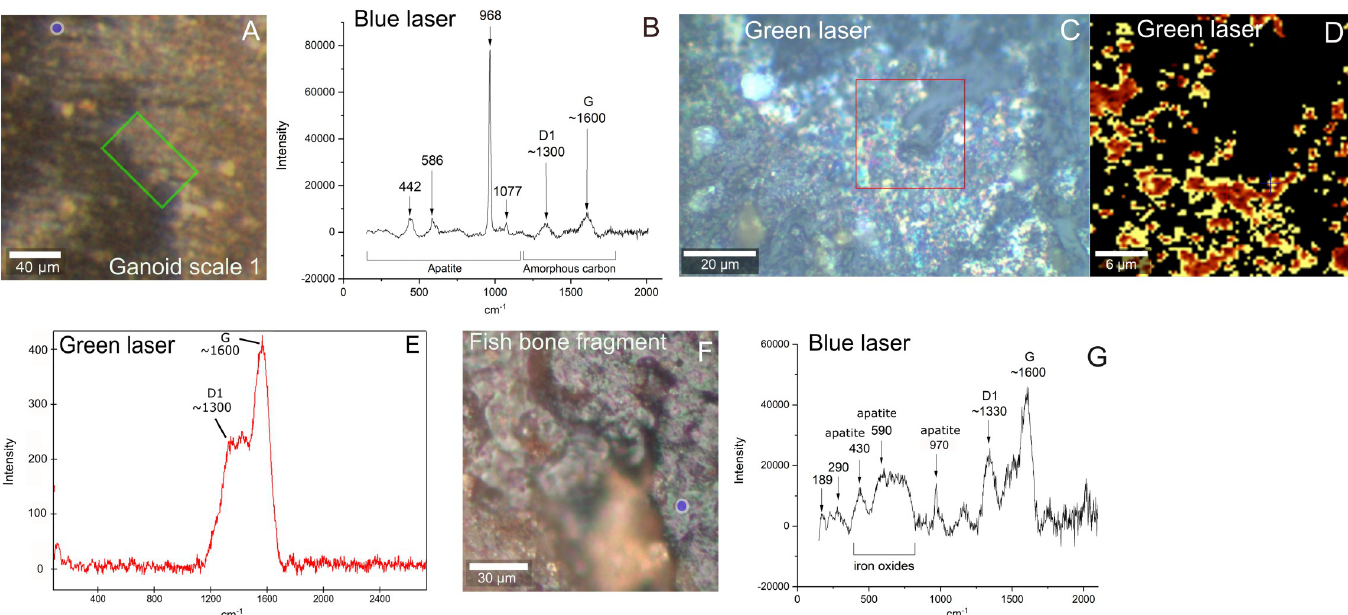
Fig 4. Chemical and mineralogical characterization of Messel fossil scale and bone fragment by Raman. A) Micrograph of ToF-SIMS area on ganoid scale 1 with gray- brown film (Fig 1A and 1B). B) Blue laser Raman spectrum from blue circle in area of film on fish scale in A. C) Micrograph of area in green square in A where green laser Raman scan was performed. Note that scale is rotated compared with A. D) Raman map of D1 peak of red area in C. E) Summed Raman spectrum of scan in red square in C) indicating refractory carbon. F) Micrograph of ToF-SIMS area on bone fragment (Fig 1E and 1F). Blue circle indicates area of Raman analysis on porphyrin-rich area identified by ToF-SIMS. G) Blue laser Raman spectrum of blue circle on bone fragment in F.